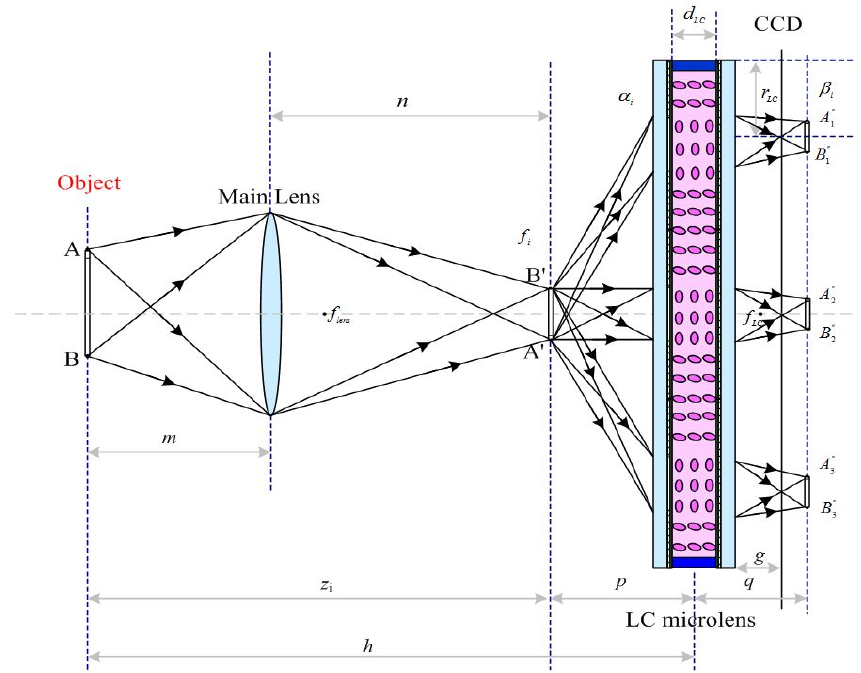
Figure 5. The schematic imaging system setup of the light field imaging based on LC